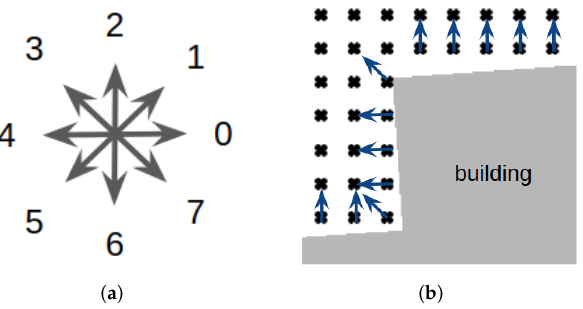
Figure 4. ( a ) shows the eight possible broadside directions for the array when mounting an AP on a wall. ( b ) is an example of the broadside directions for different potential AP locations. The dark gray area represents a building. The black dots next to the building are the potential AP locations. The blue arrows indicate the broadside directions for each potential AP